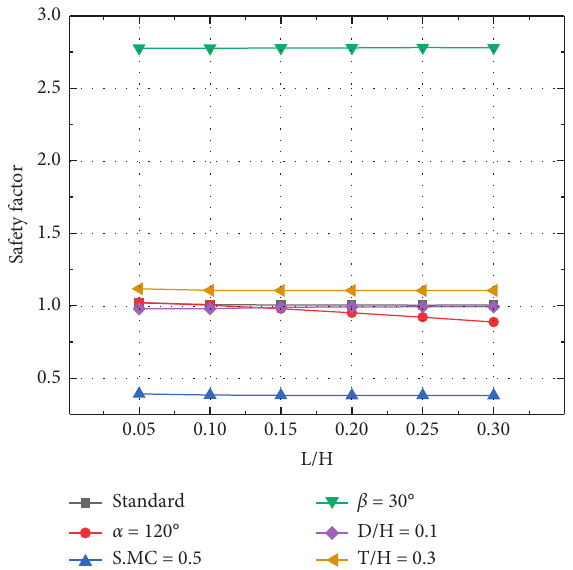
Figure 15: The influence of the crack length on slope stability.